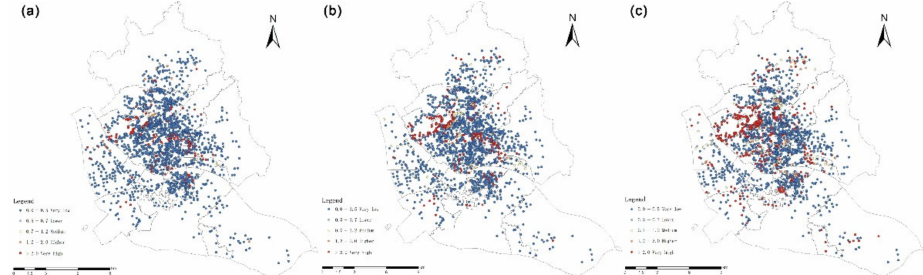
Figure 7. Locational entropy at residential scale under different traveling scopes ( a ) 5-min life circle. ( b ) 15-min life circle. ( c ) 30-min life circle.